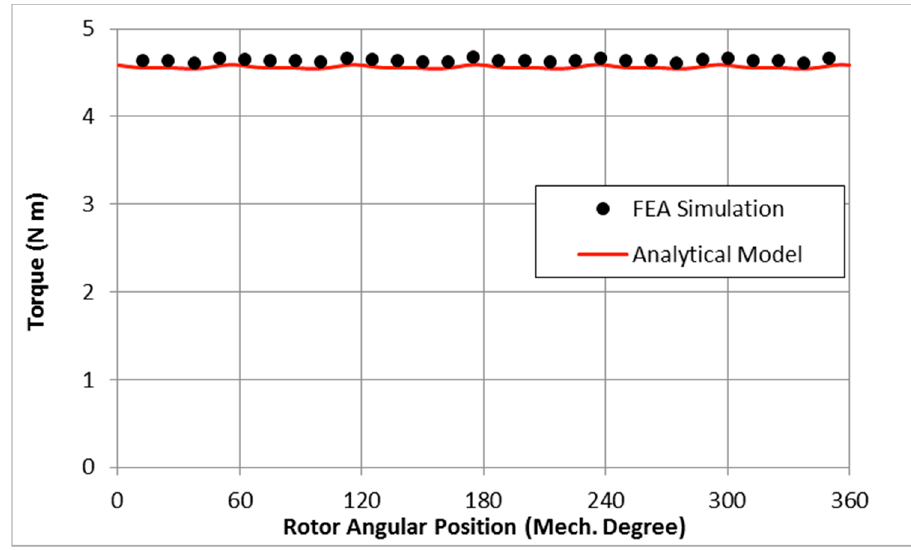
Figure 8. Analytical and MotorSolve FEA Predictions of Electromagnetic in the 12 s/10 p Halbach Machine with R mp = 0.5 (average deviation: